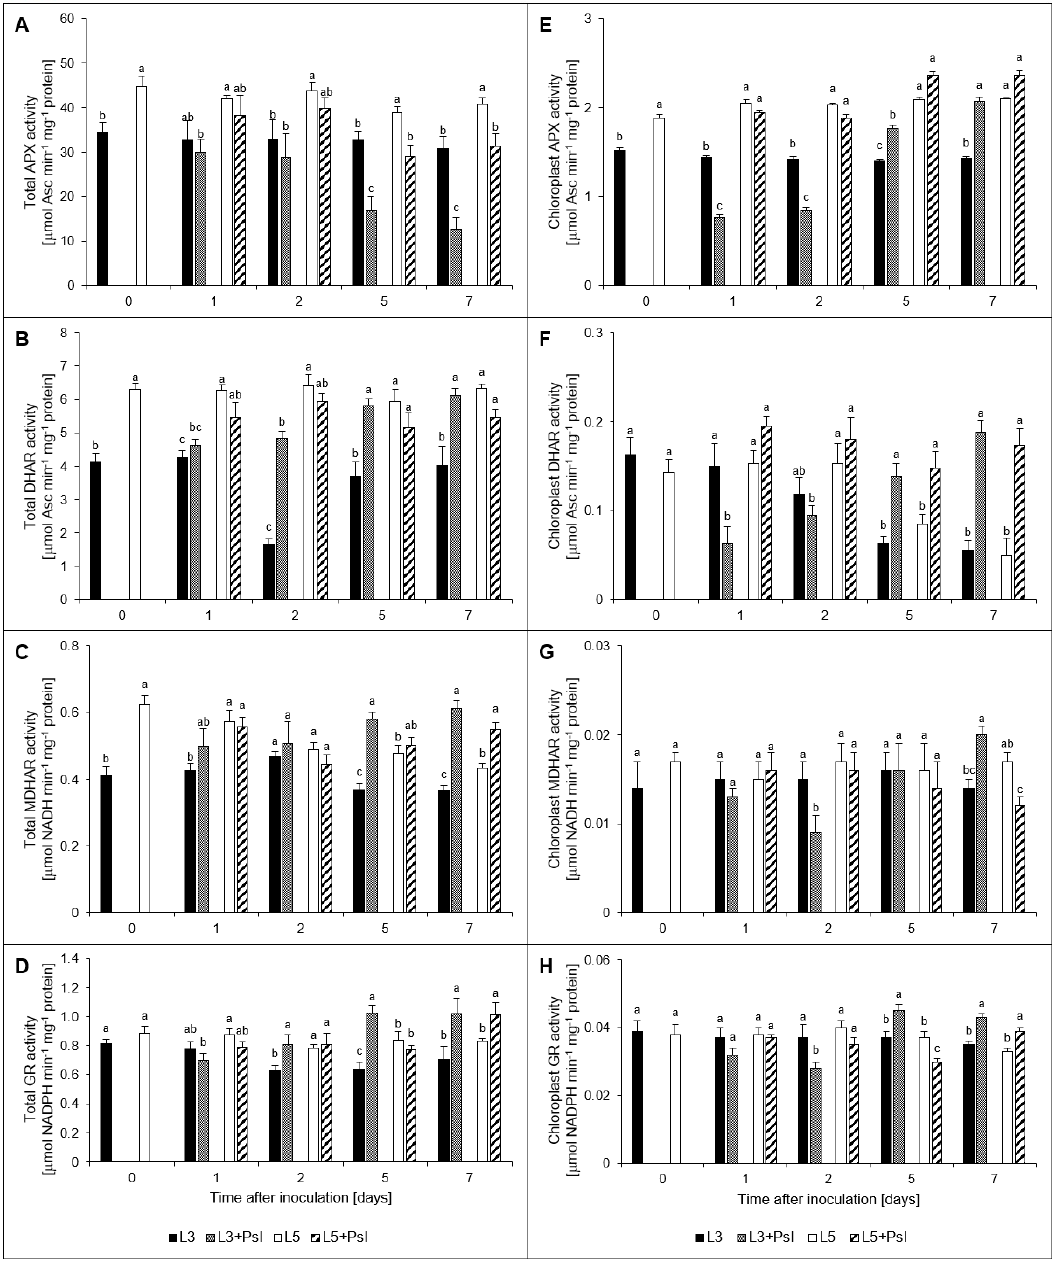
Figure 6. Ascorbate–glutathione cycle enzymes activities. Total activities ( A – D ) and chloroplast enzymes activities ( E – H ) were measured; ( A , E ) ascorbate peroxidase (APX) activities; ( B , F ) dehydroascorbate reductase (DHAR) activities; ( C , G ) monodehydroascorbate reductase (MDHAR) activities; ( D , H ) glutathione reductase (GR) activities. Values are means of four replicates ( ± SD). Di ff erent letters (a,b) indicate significant ( p ≤ 0.05) di ff erences between experimental variants within a given time